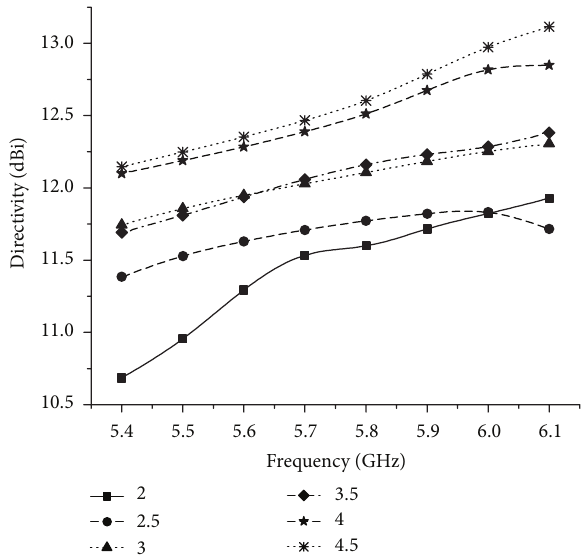
Figure 10: Comparison of the simulated reflection coefficient of the 1st iteration and 2nd